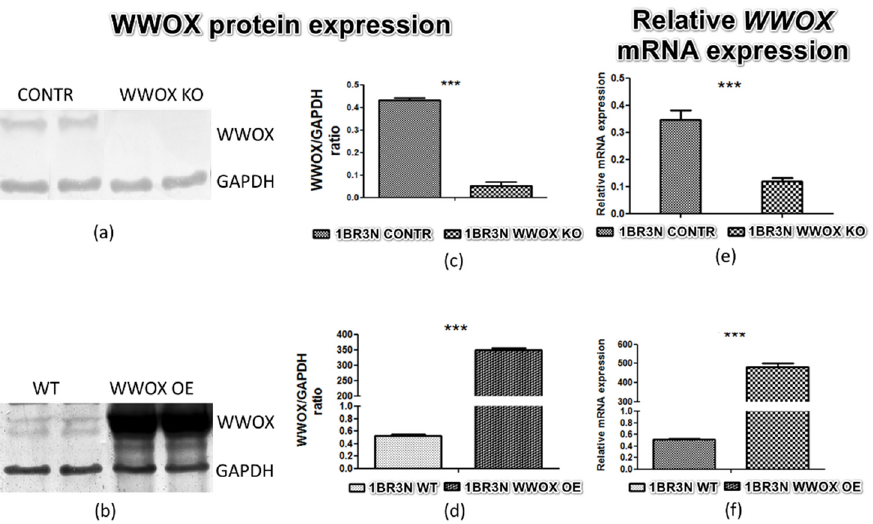
Figure 1. Confirmation of 1BR.3.N cell line transfection on the protein level ( a , b ), calculated relative protein expression (OD WWOX/OD GAPDH) ( c , d ) and relative WWOX mRNA expression ( e , f ). The values are mean ± SEM. ***, p < 0.001.